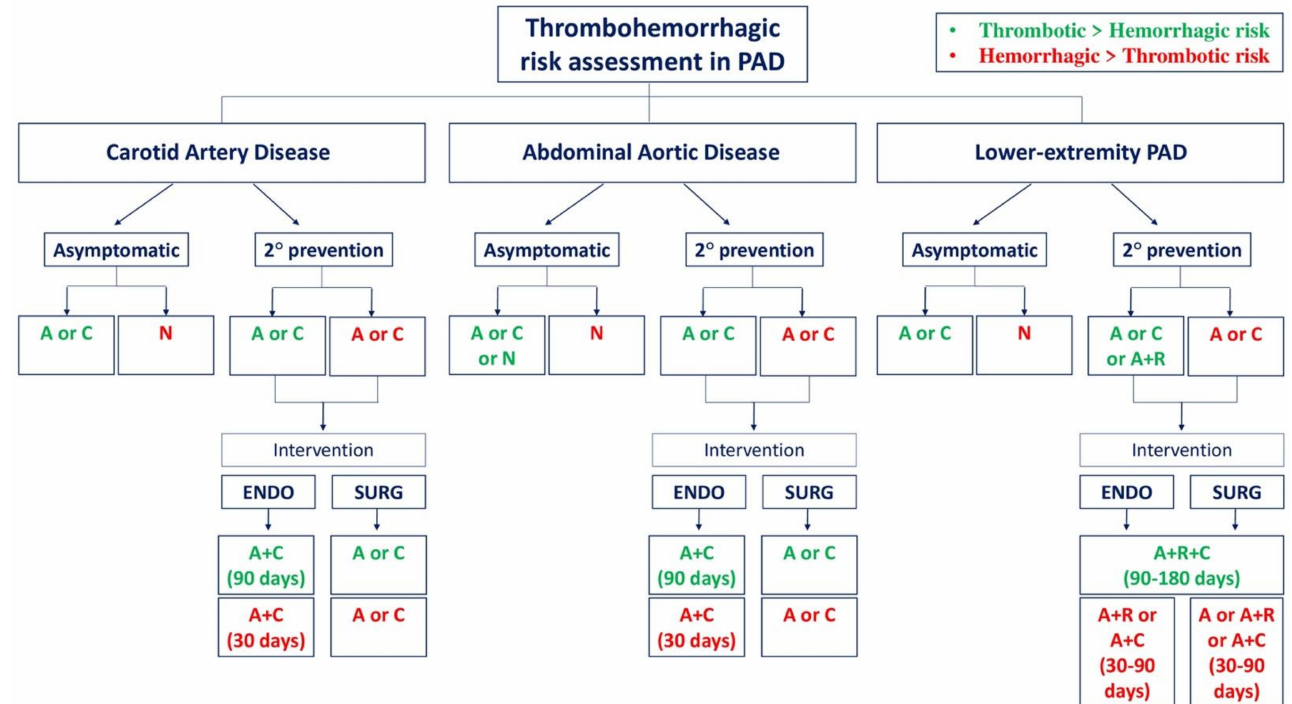
Figure 2. Proposed algorithm for antithrombotic management in patients with PAD asymptomatic or in sec- ondaryprevention. A=low-doseaspirin,C=clopidogrel75mg/day, N=nomedicaltherapy, R=rivaroxaban 2.5 mg/twice daily, ENDO = endovascular revascularization, SURG = surgical